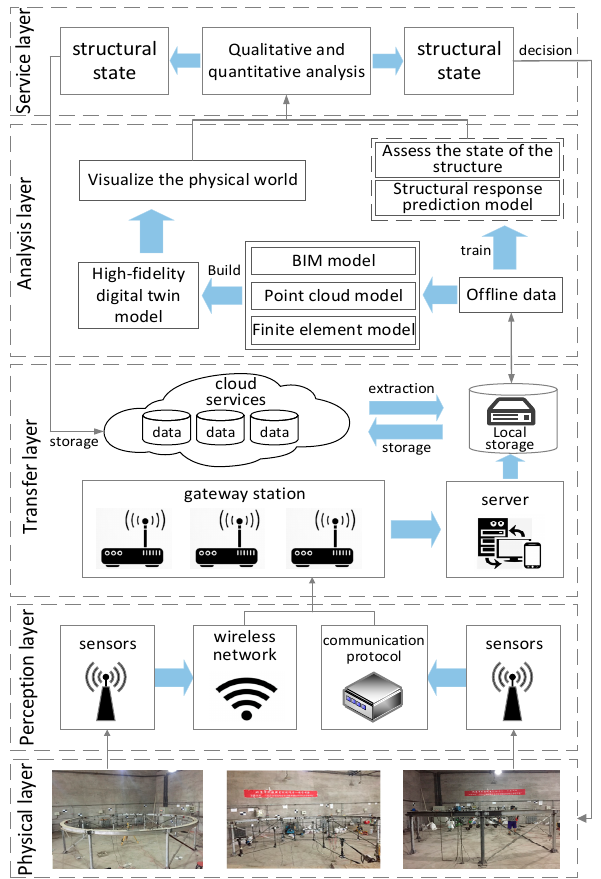
Figure 3. The overall framework for impact response prediction of structures.